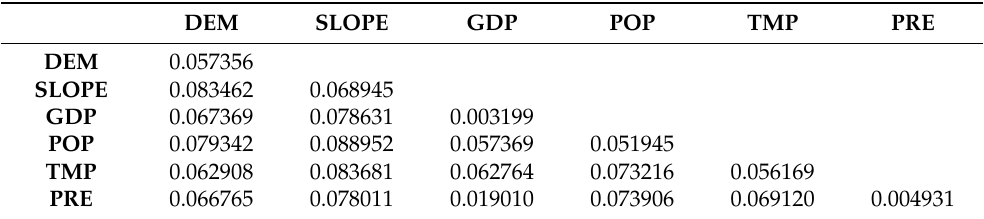
Table A5. The force (q-value) among any two influencing factors on Percentage of Landscape (PLAND) interactively in 1990.